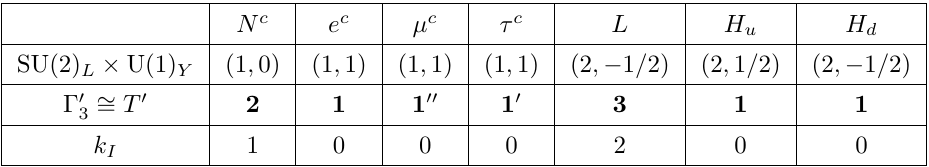
Table 2 . The transformation properties of the MSSM chiral super(cid:12)elds under Standard Model gauge group SU(2) L (cid:2) U(1) Y and under T 0 modular symmetry, (cid:0) k I refers to the modular weight under the modular